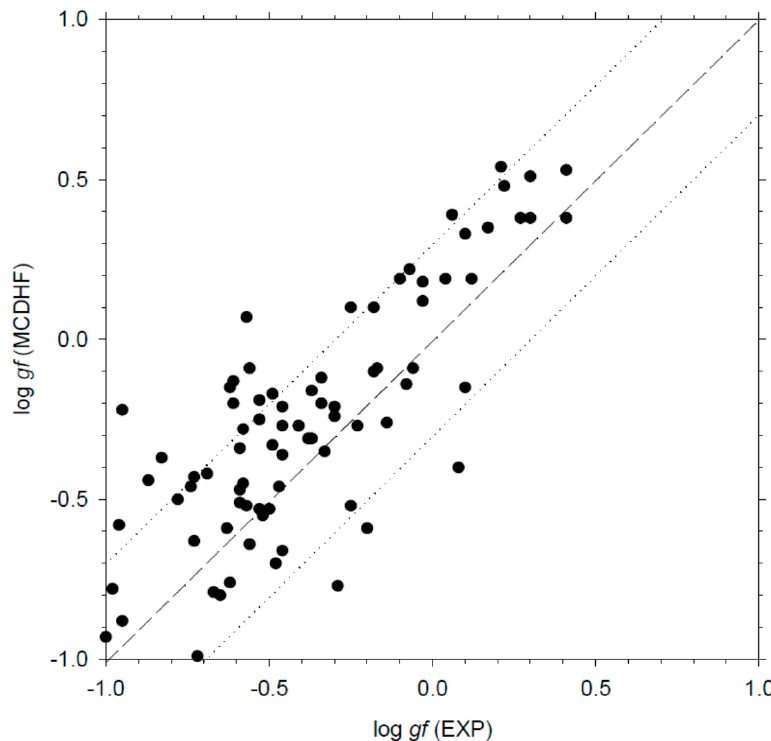
Figure 5. Comparison between the oscillator strengths (log gf ) computed in the present work using the MCDHF model and the available experimental values [22]. The dashed line corresponds to a perfect agreement while the dotted lines correspond to a discrepancy of a factor of two on the gf ‐ values.